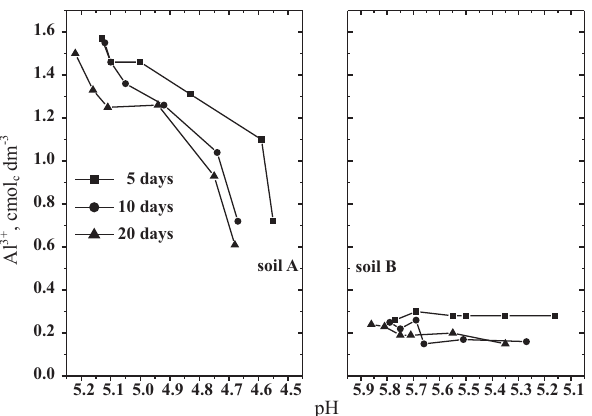
Figure 2. Exchangeable aluminum with increasing acidity in different incubation times in soils A and B.